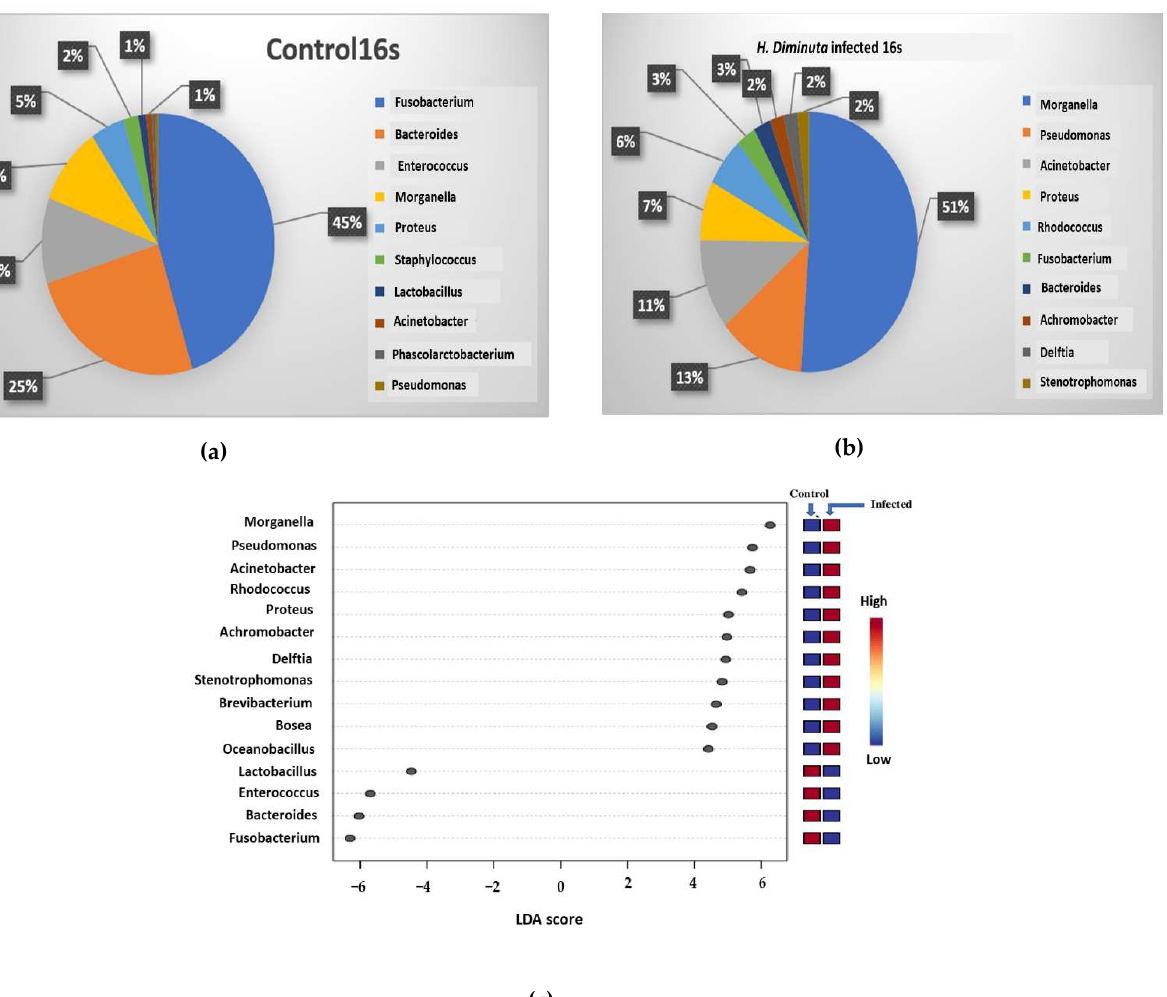
Figure 4. Percentage of top 10 genera of micro bacteria present in the gut of ( a ) Control and ( b ) In- fected; ( c ) Linear Discriminant Analysis showing OUT maximum probability of abundance of differ- ent Genera in control and infected host gut.